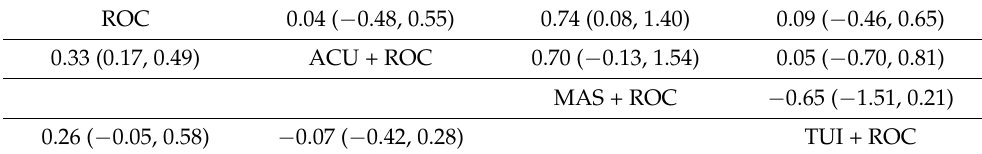
Table 3. Network league table of FEV1 (L) (right upper part) and FVC (L) (left lower part). ROC 0.04 ( − 0.48, 0.55) 0.74 (0.08, 1.40) 0.33 (0.17, 0.49) ACU + ROC 0.70 ( − 0.13, 1.54) − 0.07 ( − 0.42, 0.28) TUI + ROC